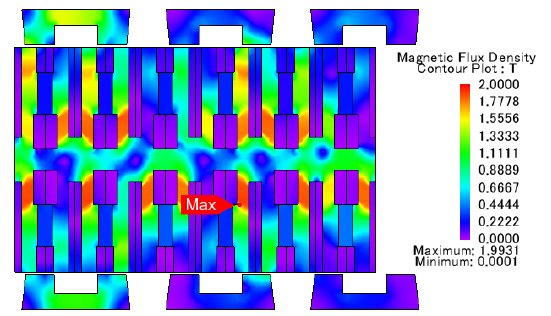
Figure 24. Flux distribution of the